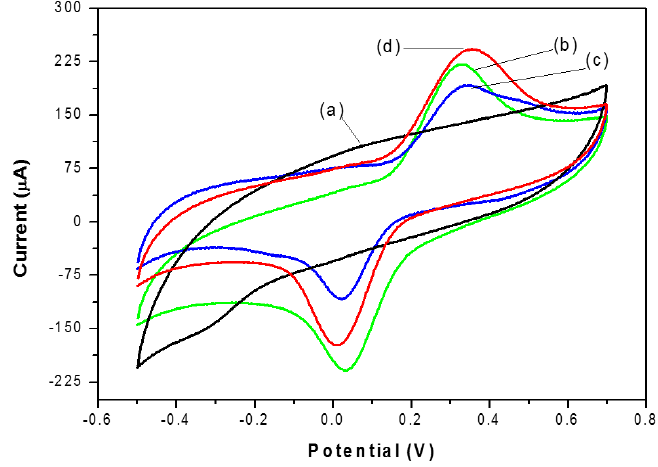
Figure 4. Shows cyclic voltammograms of: ( a ) GE; ( b ) NAF/LAC; ( c ) TiO 2 /LAC; and ( d ) TiO 2 /NAF/LAC in the presence of 40 mM catechol in 0.1 M SBP (pH 6.68) at a scan rate of 100 mV.